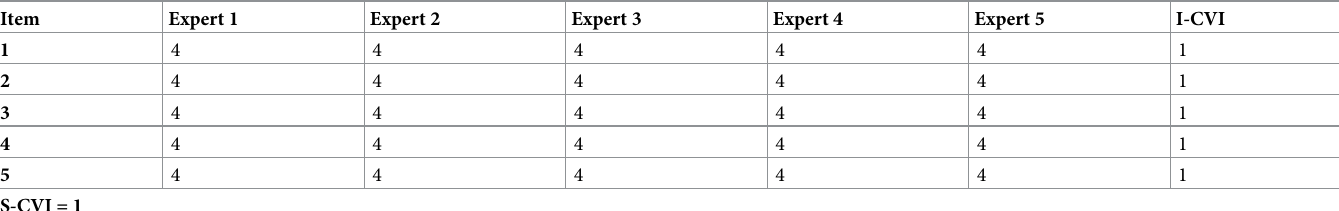
Table 1. Content validity index by 5 experts.